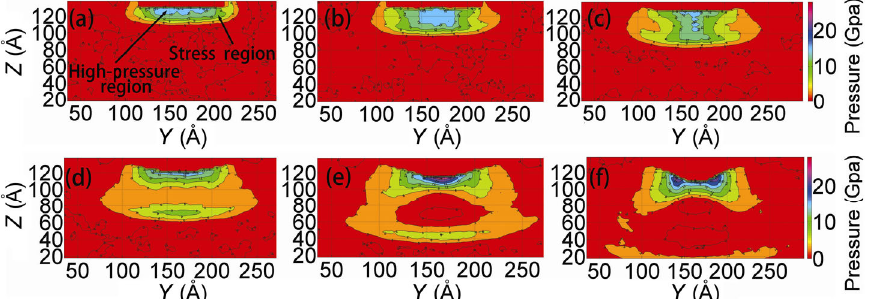
Fig. 12 Pressure distribution of silicon substrate at different moments under Pos20. (a) 750 fs; (b) 900 fs; (c) 1050 fs; (d) 1,300 fs; (e) 1,600 fs; (f) 1,950 fs.